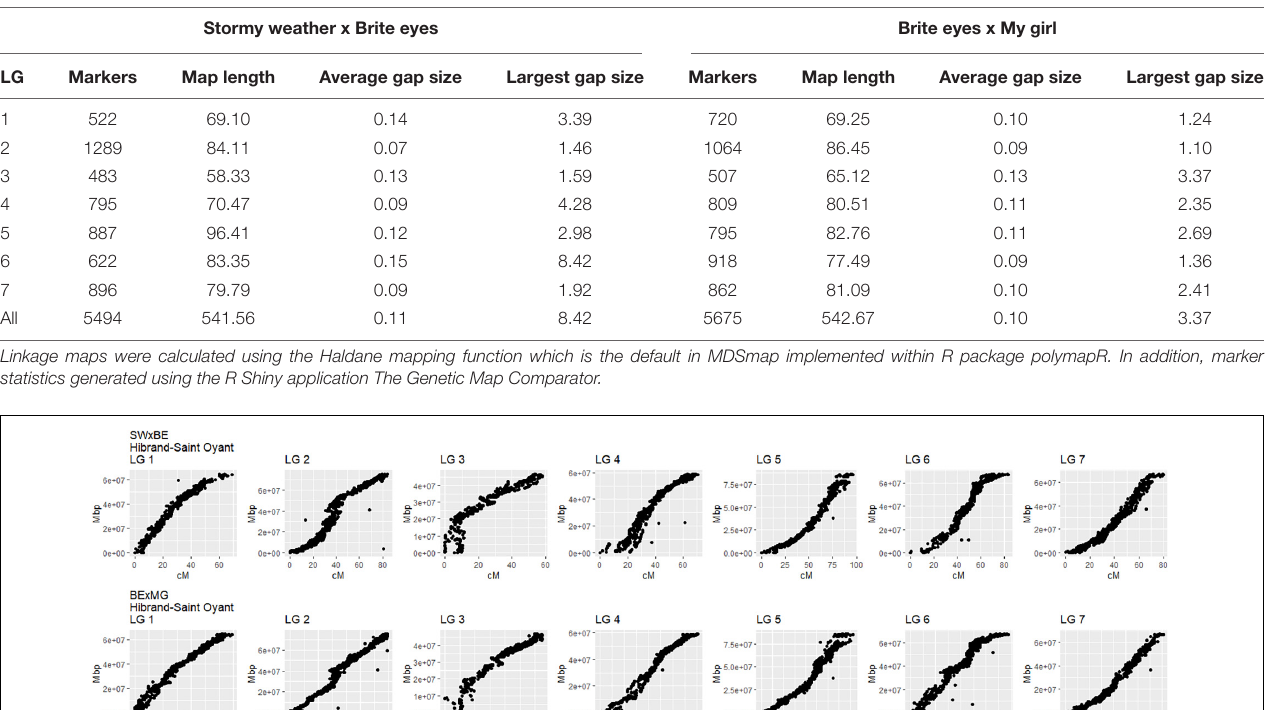
TABLE 2 | Linkage map statistics of two tetraploid garden rose mapping populations genotyped using the WagRhSNP68k SNP array and mapped using the R-package polymapR.